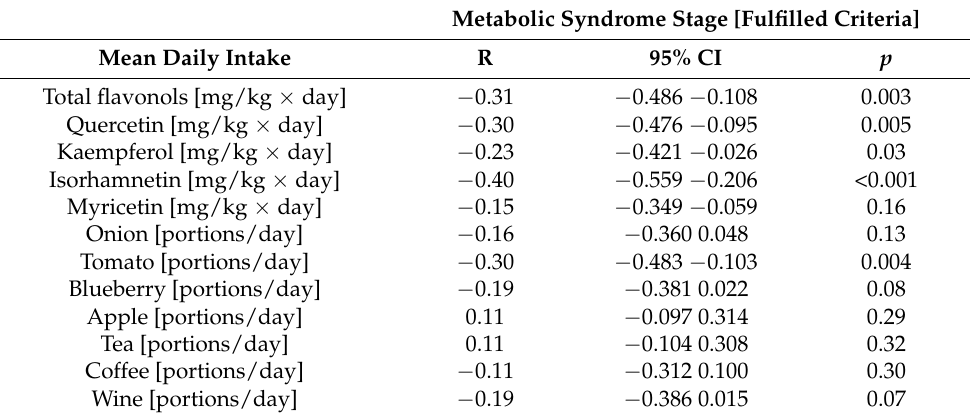
Table 3. The correlation between mean daily flavonols intake and MetS